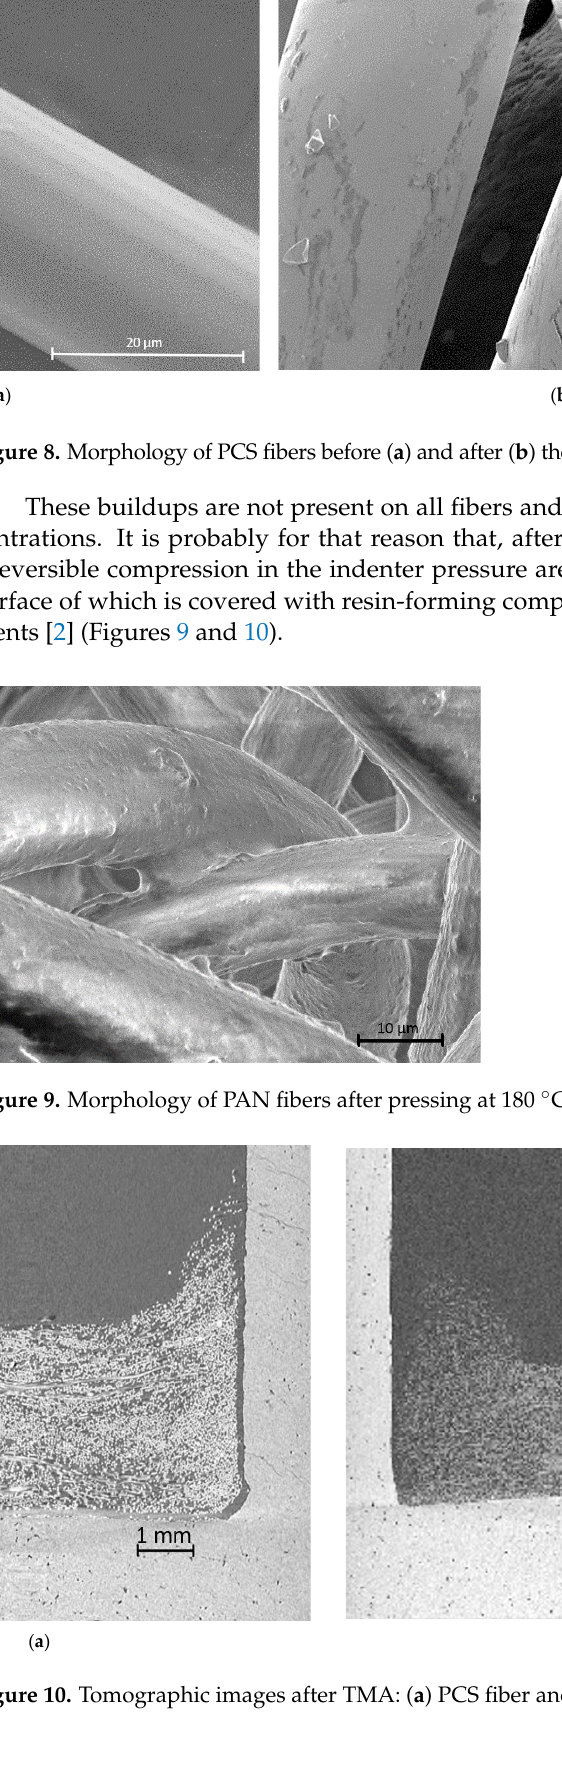
Figure 7. PCS test sample before ( a ) and after ( b ) thermomechanical analysis at up to 400 ° C. Analysis of the PCS sample microstructure after TMA shows clearly visible insular buildups on the fiber surface (Figure 8), while in the initial state the fiber surface was free of them.